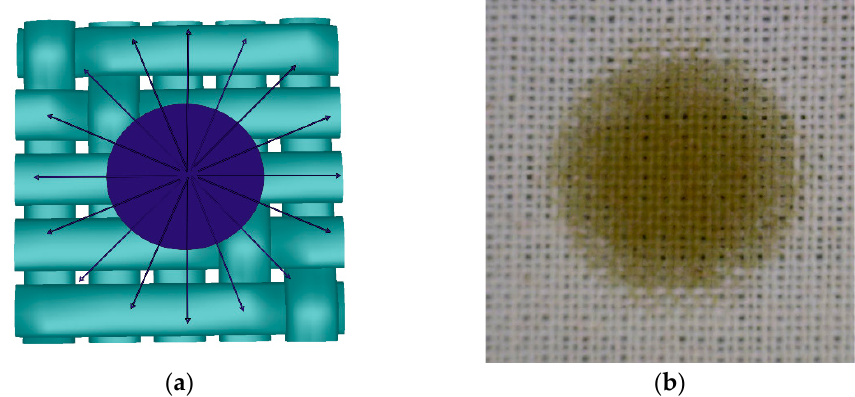
Figure 13. Distribution of drops with a uniform tendency to spread from the centre outwards: ( a ) 3D simulation; ( b ) Penetration of a pumpkin oil drop into the fibre and transfer to adjacent fibres—proper distribution, equal in all directions (bleached fabric in plain weave, density 24/24).